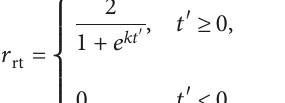
Figure 4: Relative-time rank for k